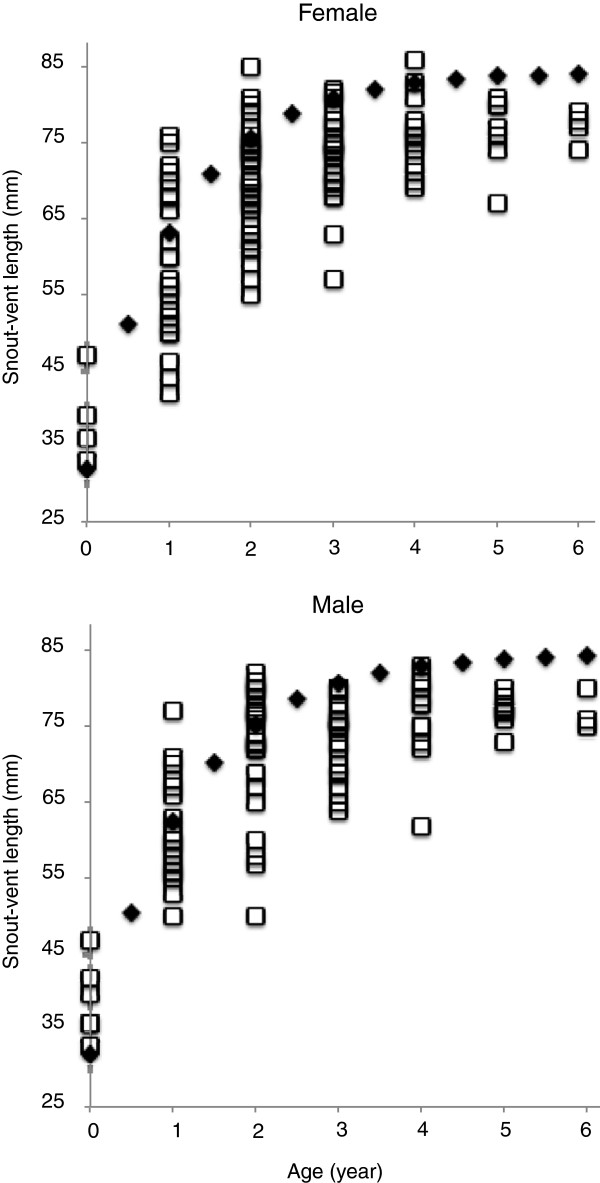
The relationship between lizard age and body size in Eulamprus leuraensis of both sexes, based on skeletochronology of 220 lizards, compared to results from the von Bertalanffy growth model applied to data from lizards captured and then recaptured in the following year. The black squares show the von Bertalanffy curve, and the grey dots show data for individual lizards.